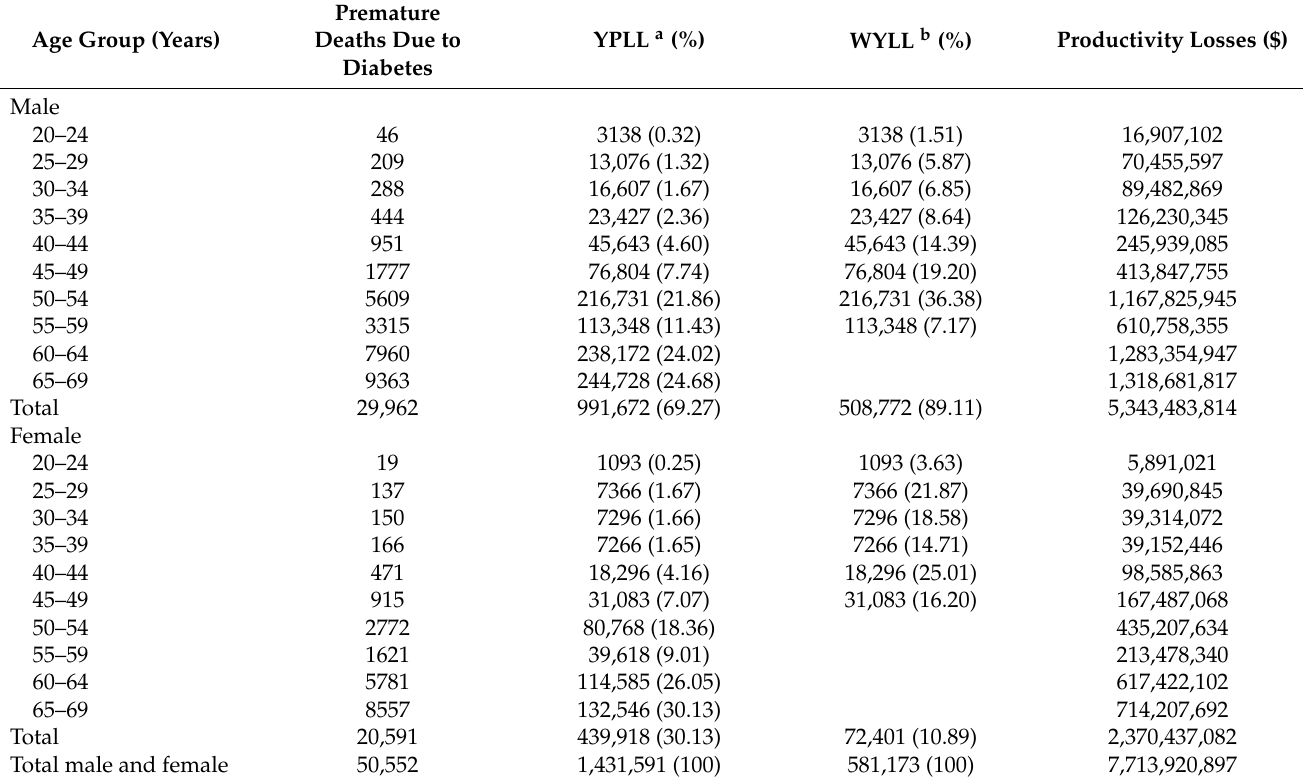
Table 3. Premature deaths, YPLL, WYLL, and productivity losses due to diabetes for urban workers in